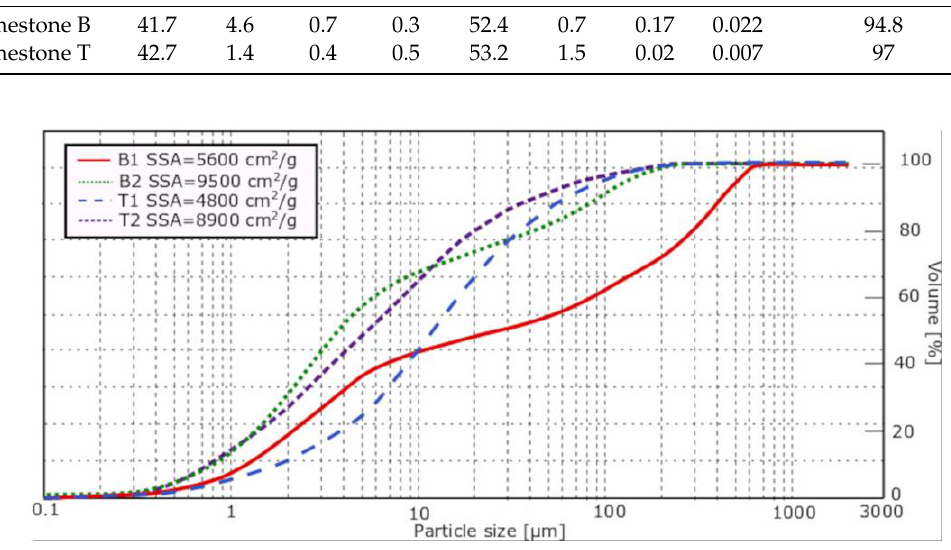
Figure 3. Particle size distribution of limestone used in the research.